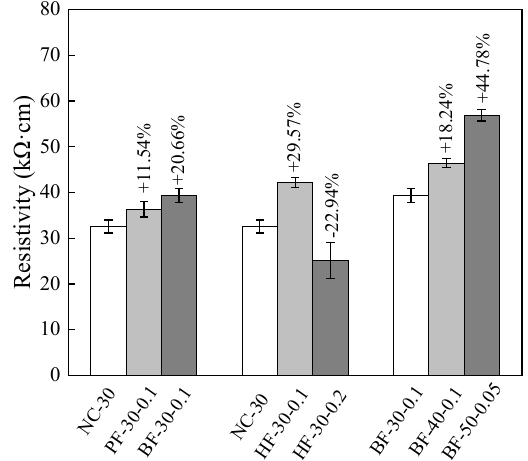
Figure 3. Resistivity of specimens.